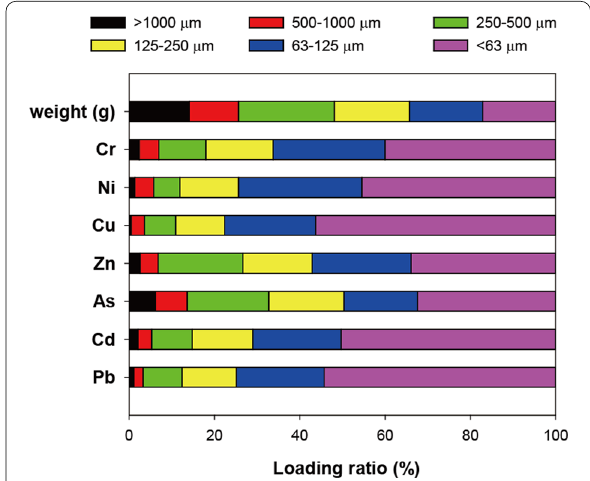
Fig. 5 Heavy metal loading percentage (%) of six different particle sizes in